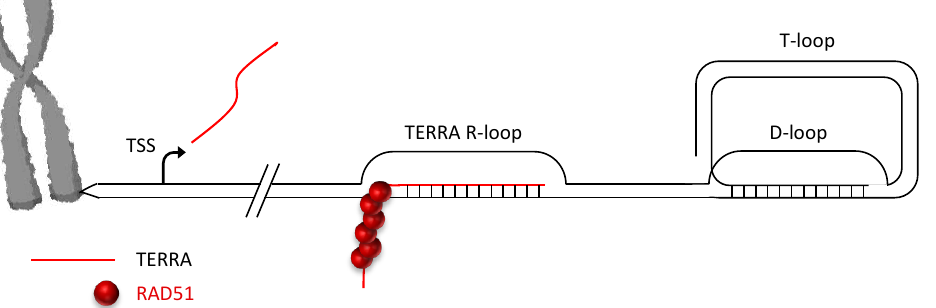
Figure 6. Nucleoprotein structure of the chromosome ends. Telomeres have a 3' overhang, which can invade the dsDNA region, forming a D-loop termed the T-loop. Telomeres are transcribed into TERRA (red line). The TERRA transcription starts in sub-telomeric regions, extending towards the chromosome ends. The TERRA association and R-loop formation at telomeres depend on RAD51, which binds the TERRA and catalyze the TERRA R-loop formation in vitro . Red spheres: RAD51 protein.